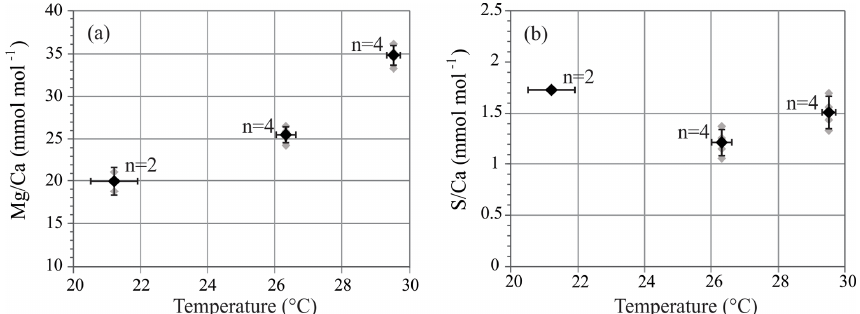
Figure 3. Mg / Ca (a) and S / Ca (b) of A. lessonii from the controlled temperature experiment. Sector field ICP-MS measurements (grey symbols) and average values ± SD (black symbols) of grouped specimens. Horizontal error bars represent ± SD of temperature conditions. n is number of groups measured.